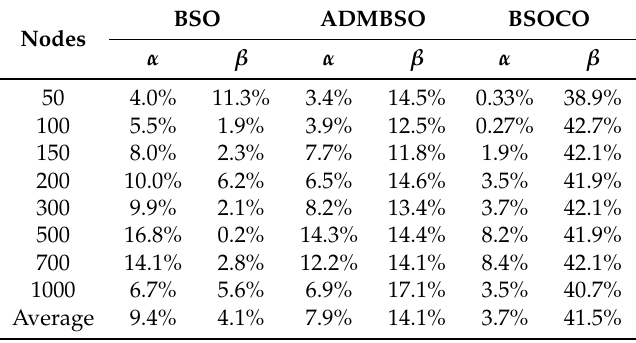
Table 5. Comparison between the IBSO and BSO and two improved BSO algorithms. BSO Nodes